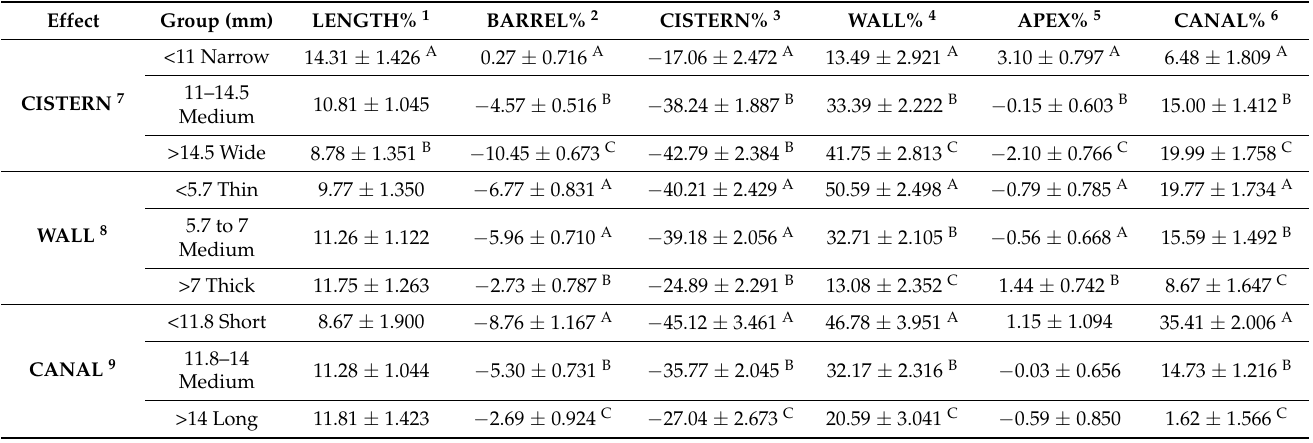
Table 3. The effect of teat cistern width, wall thickness, and canal length on the least-square means ± SEM of milking-induced changes in teat